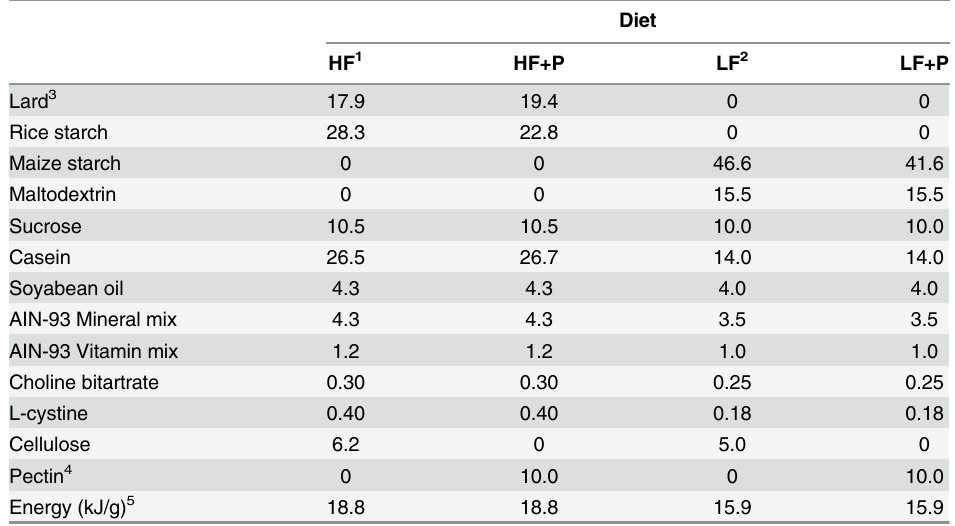
Table 1. Diet composition. Composition of experimental diets (% w/w) and energy content.